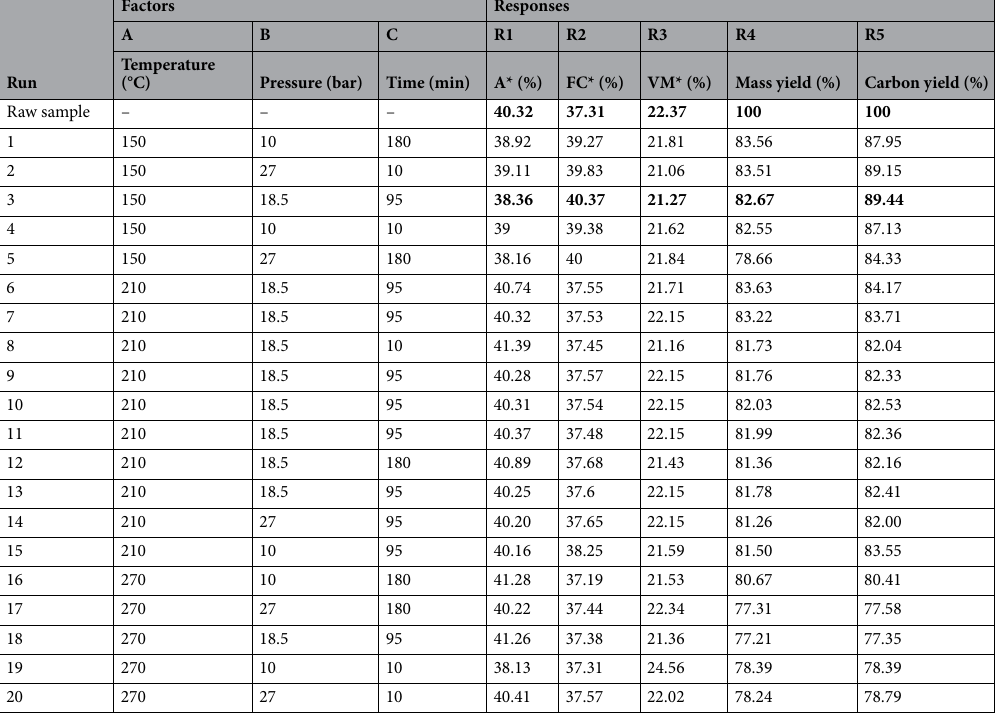
Table 3. Physicochemical analysis results of produced HC from coal tailing (CT). Significant values are in bold. A ash content, FC fixed carbon, VM volatile matter. *Dried basis (moisture free). Solid/liquid ratio: 1/4.